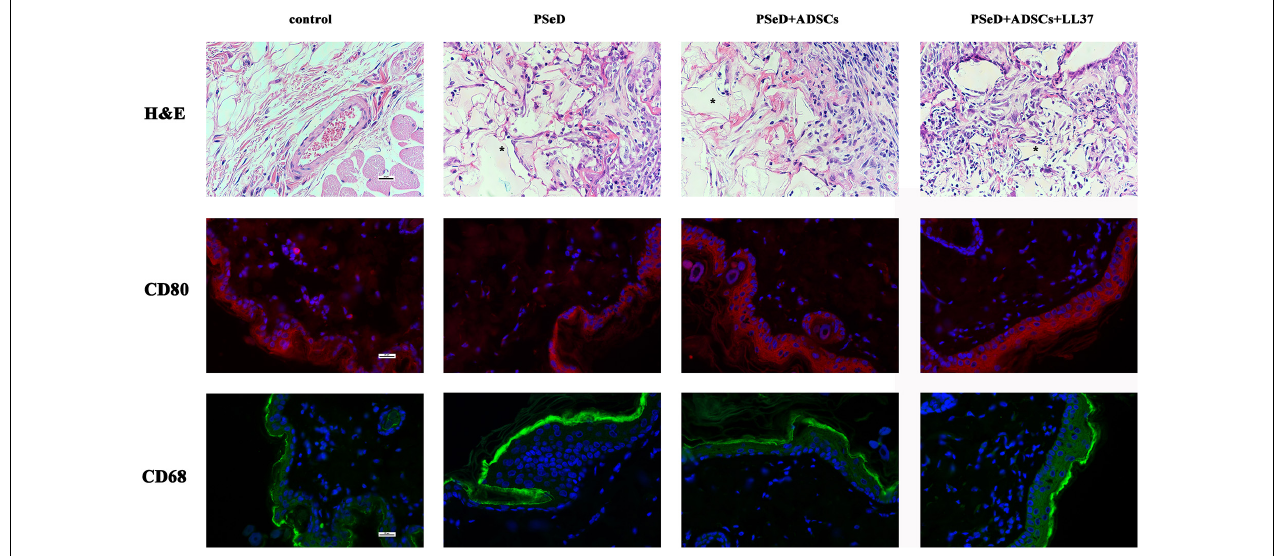
FIGURE 4 | Representative photomicrographs of H&E staining sections and immunofluorescence staining for CD68/CD80 positive macrophages. First row: H&E staining, PSeD is shown as pink-glass-like opacities and was marked with *. Second and third rows: Immunofluorescent staining of macrophage-specific markers, CD80 for M2 and CD68 for M1. Each row contains photos of four groups: (1) control group with no implant; (2): PSeD; (3): PSeD + ADSCs; (4): PSeD + ADSCs + LL37. There was no significant difference amongst the four groups. All photos were taken at 400 times magnification. The scale bar is 25 µ m.